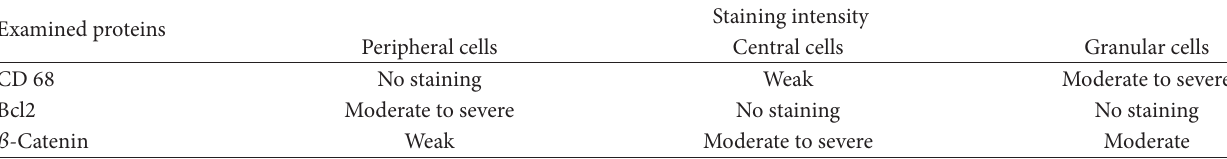
Table 1: The expression of CD 68, Bcl2, and 𝛽 -catenin in the cytoplasm of tumor cells in a granular cell ameloblastoma. Examined